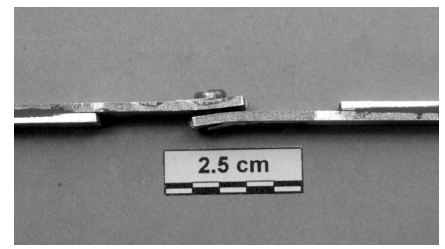
Fig. 6. Shear test failure mode.